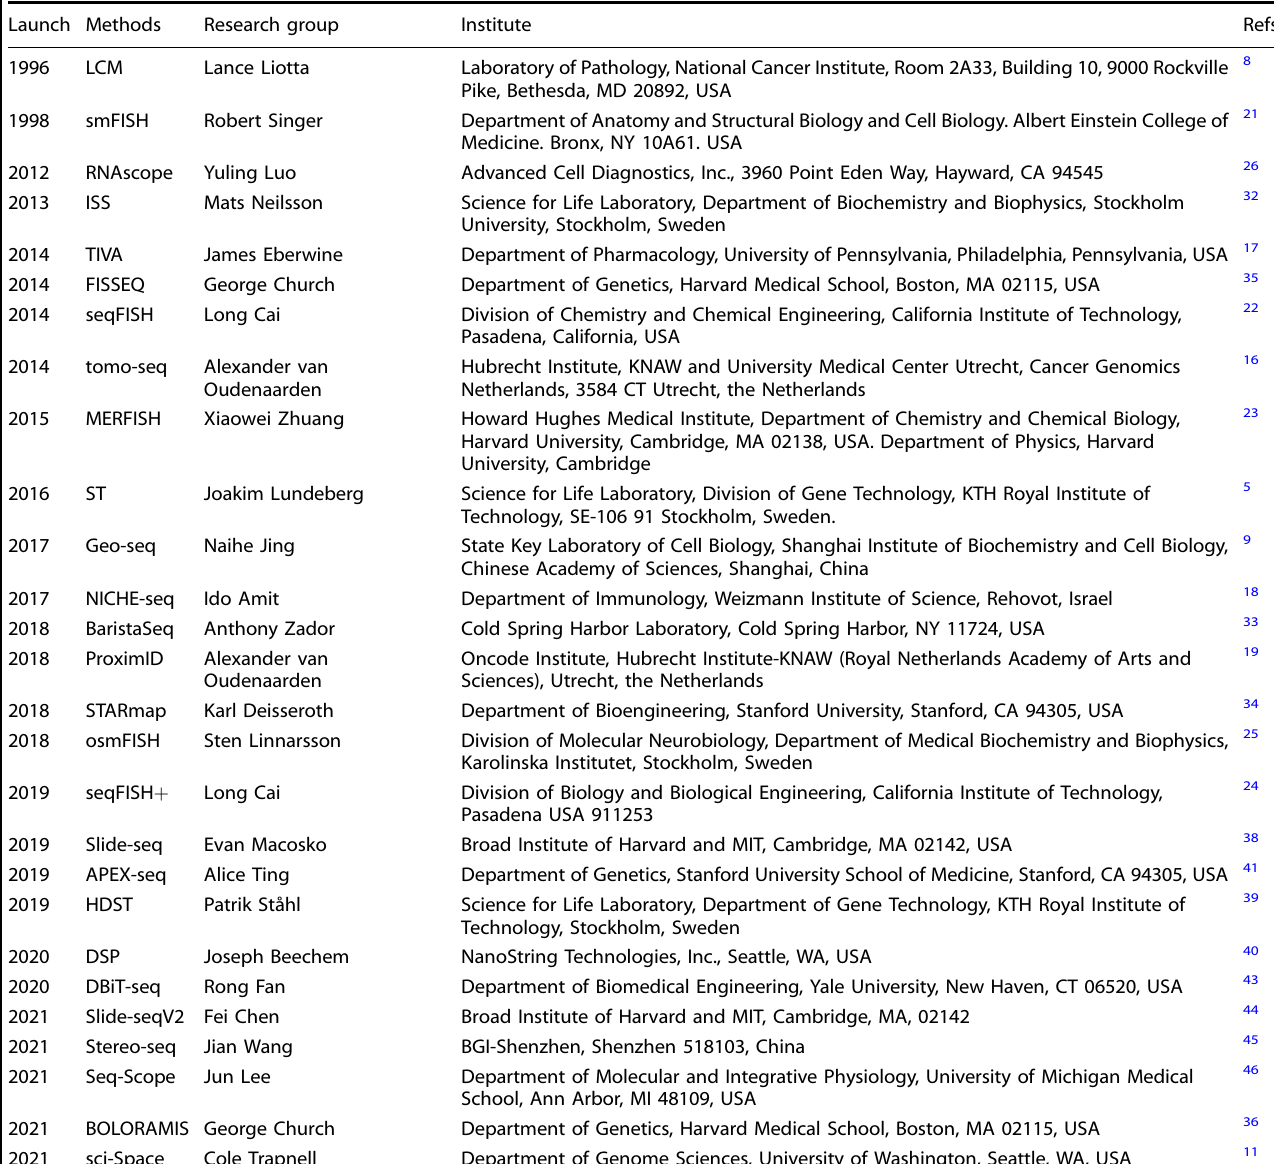
Table 1. List of representative ST technologies Launch